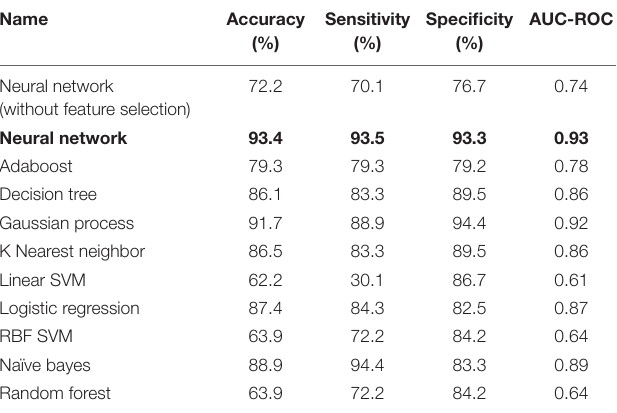
TABLE 3 | Performance metrics for the different classifiers with the AD